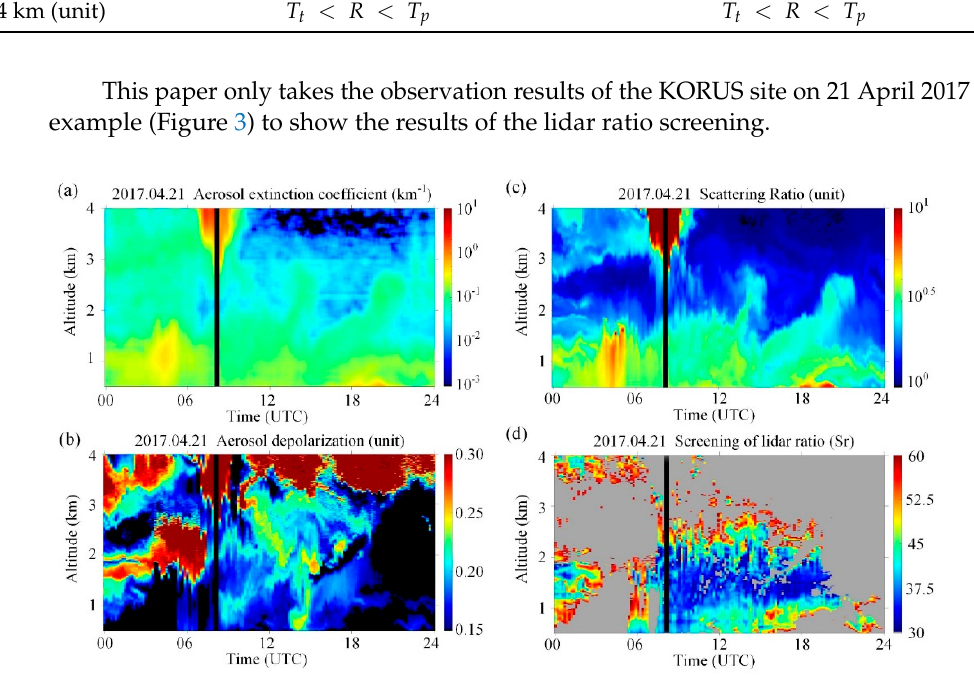
Figure 3. The screening results of dust-dominated observations with the lidar ratio at the KORUS site based on HSRL on 21 April 2017. ( a ) Aerosol extinction coefficient; ( b ) Scattering ratio; ( c ) Aerosol depolarization ratio; ( d ) Selection of dust-dominated lidar ratio result by screening criteria (grey represents the screened part).